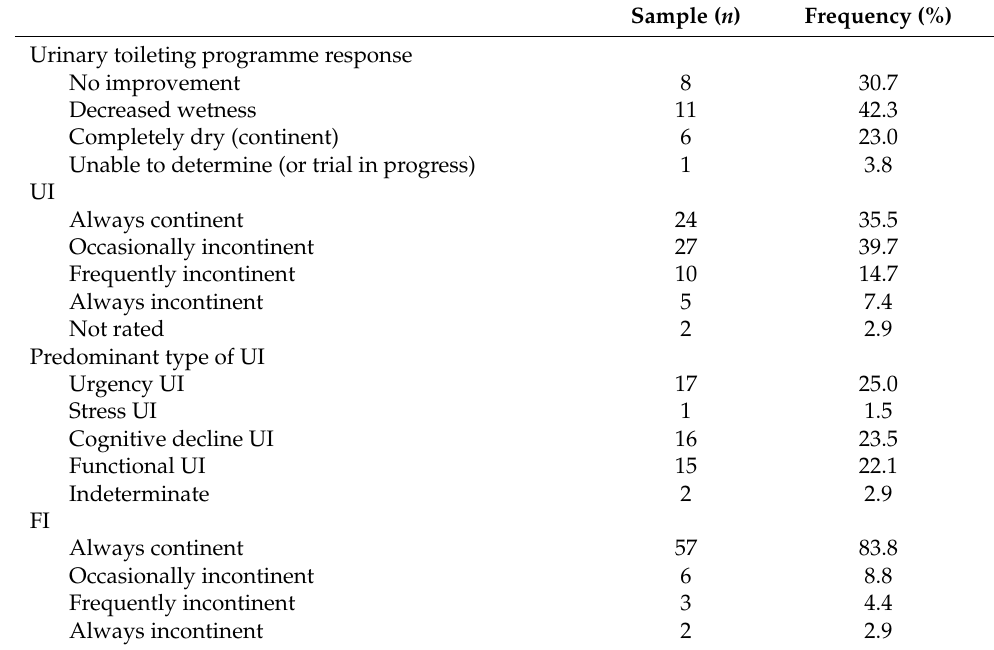
Table 3. Urinary incontinence (UI) and fecal incontinence (FI) characteristics according to Mininum Data Set (MDS) among 68 residents living in five nursing homes (NHs) from Osona, Spain